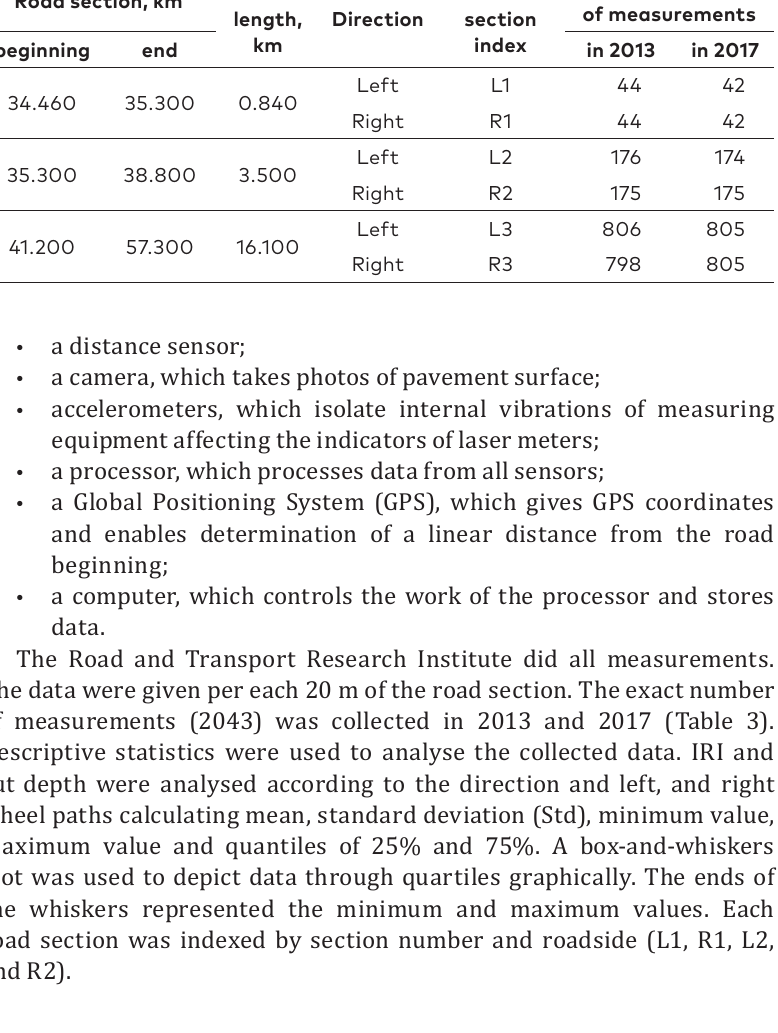
Table 3. Measurements on the road No. A16 Vilnius−Prienai−Marijampolė Road section,